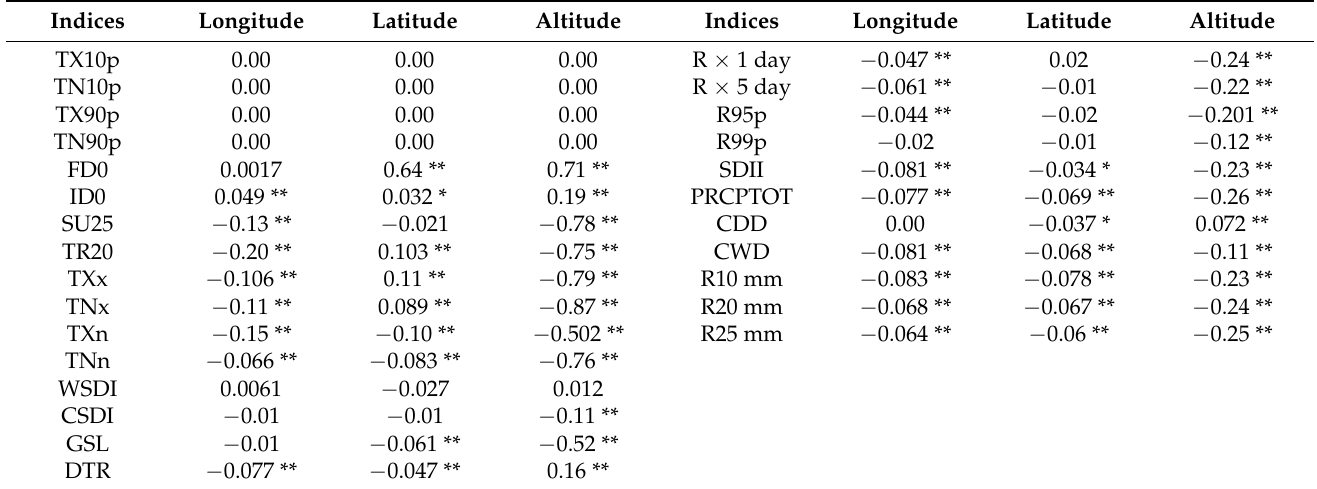
Table 3. Correlation coefficient between the linear trends in extreme temperature indices and geographical parameters in Yunnan. Indices Longitude Latitude Altitude Indices Longitude Latitude